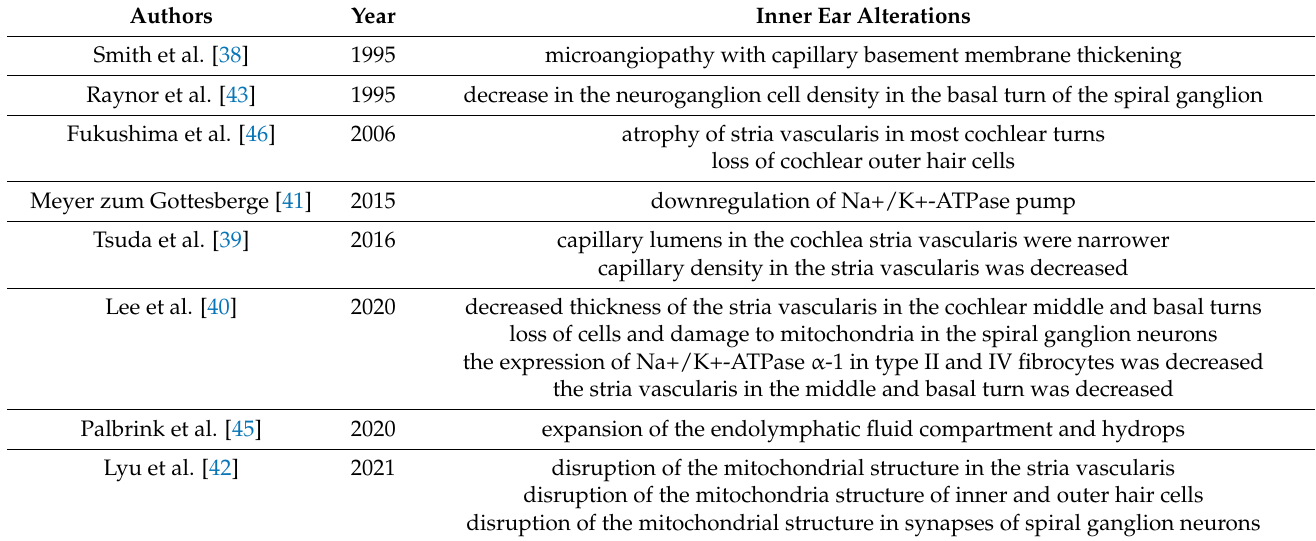
Table 1. Inner ear alterations observed in experimental models with (Diabetes Mellitus)